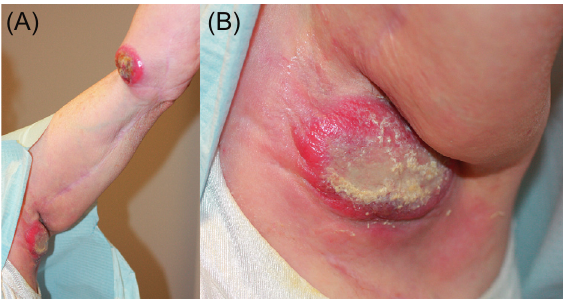
Figure 3. Aggressive tumors such as this synovial-cell sarcoma, stage G3T2bN1M1, require very invasive surgery and a customized reconstructive solution (in this case radical forequarter amputation with chest wall resection with a myocutaneous latissimus dorsi flap was planned). Neoadjuvant therapy was scheduled prior to surgery, however, the patient succumbed to the disease secondary to pulmonary